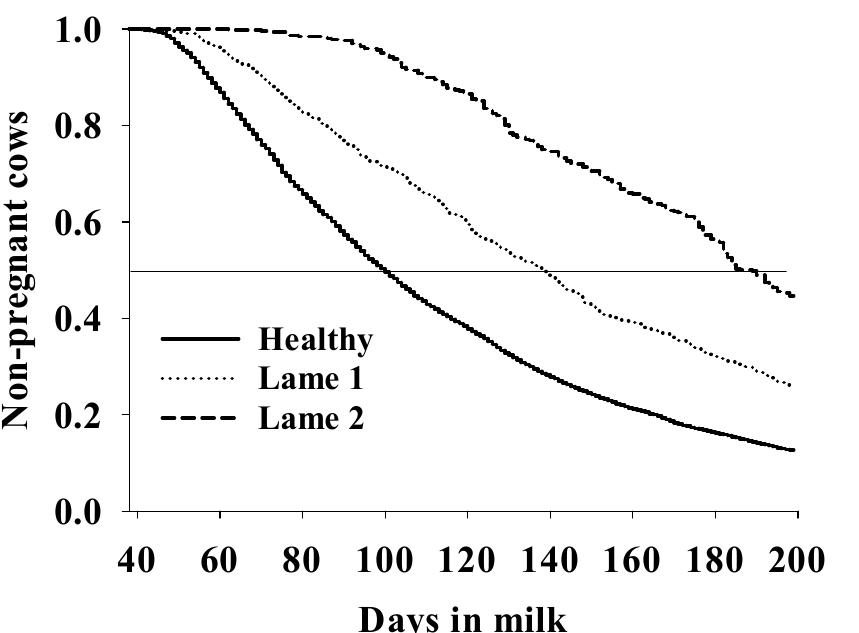
Figure 2. Association between the timing of lameness case occurrence in lactation with calving to pregnancy interval in grazing dairy cows (n: 7156) from a commercial dairy herd evaluated for 7.5 years (January 2010–June 2017). Healthy cows had a median (95%CI) calving to first pregnancy interval of 101 (99–103) days; lame 1 cows had an interval of 139 (132–144) days, and lame 2 cows had calving to first pregnancy interval of 188 (183–196) days. Lame 1 cows had a lower hazard of first pregnancy than healthy herd mates (HR = 0.52, 95%CI = 0.46–0.59, p < 0.001), and lame 2 cows also had a lower hazard of first pregnancy than healthy herd mates (HR = 0.08, 95%CI = 0.05–0.12, p < 0.001). Finally, LG2 cows had a lower hazard of pregnancy than LG1 cows (HR = 0.53, [0.46–0.62], p < 0.001). Healthy: cows not diagnosed as lame during the entire lactation; lame 1: cows